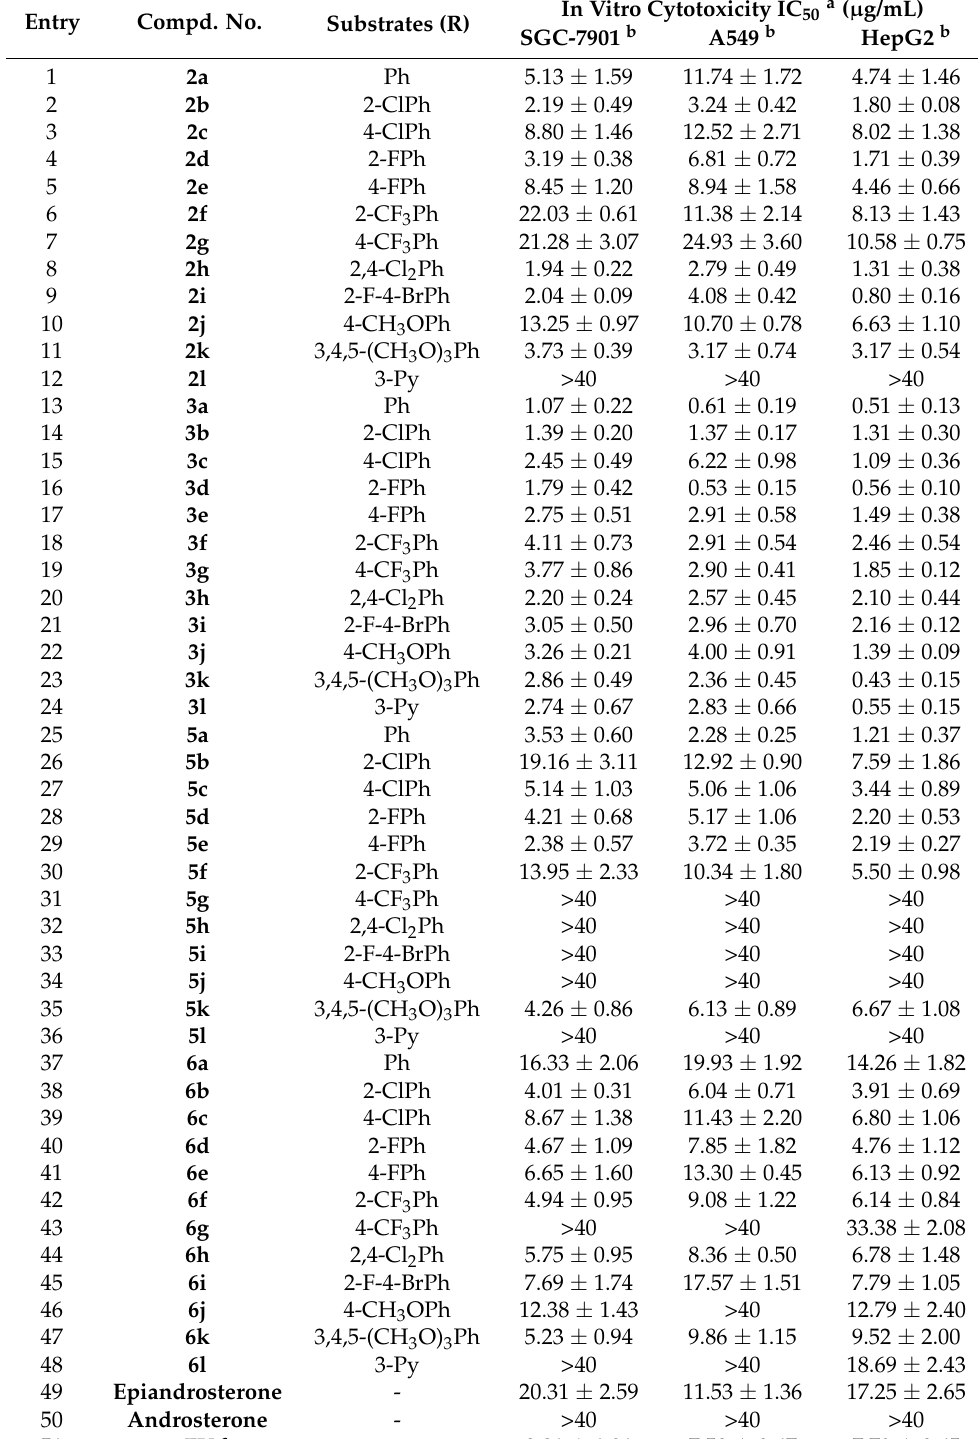
Table 1. Cytotoxic activity of the steroidal derivatives against human tumor